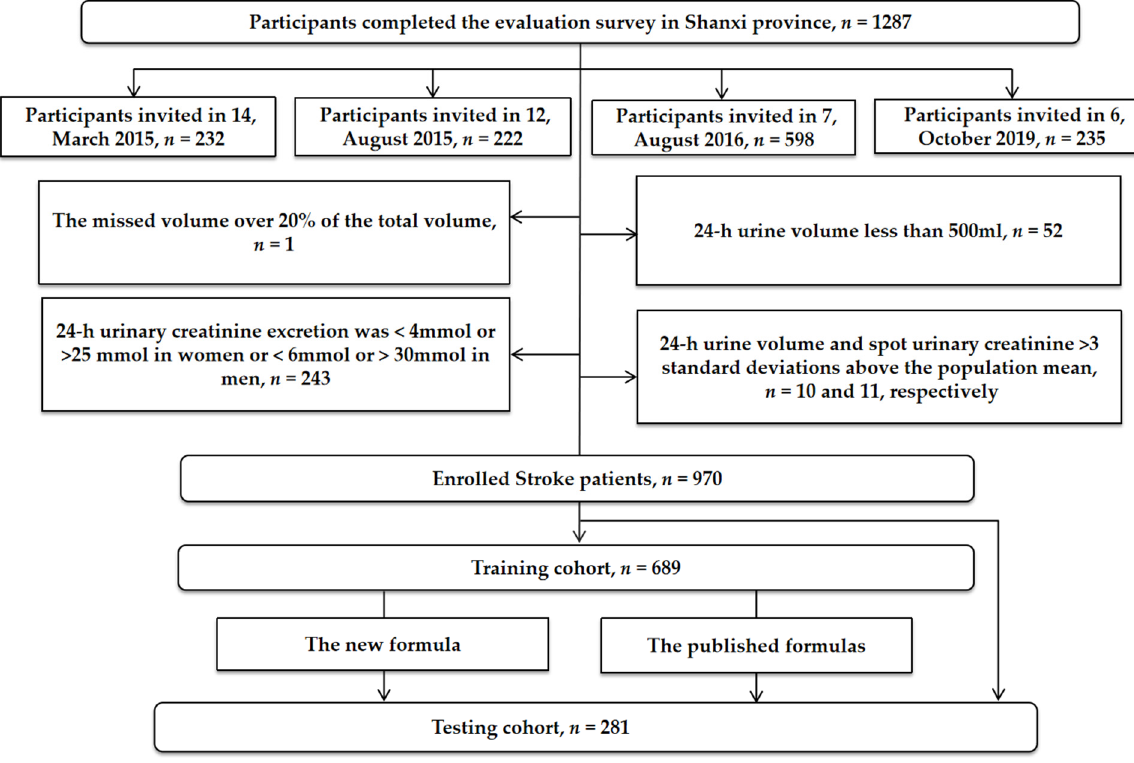
Figure 1. Flowchart for participant enrollment. Table 1. Demographic data and clinical characteristics of the study population.